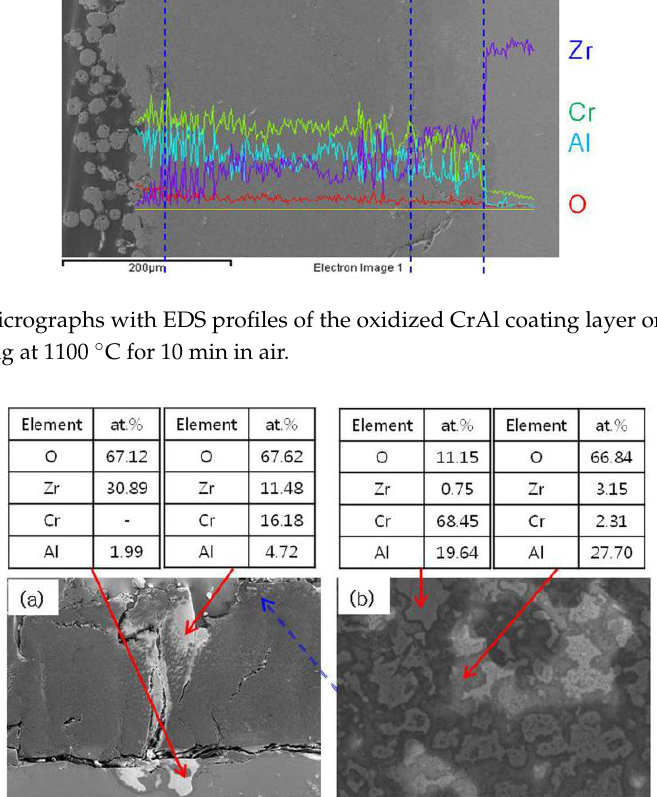
Figure 7. SEM-EDS analyses of laser coated Zircaloy-4 substrate alloy after isothermal heating at 1100 ◦ C for 30 min in air: ( a ) near the substrate; ( b ) top surface of the coating layer.